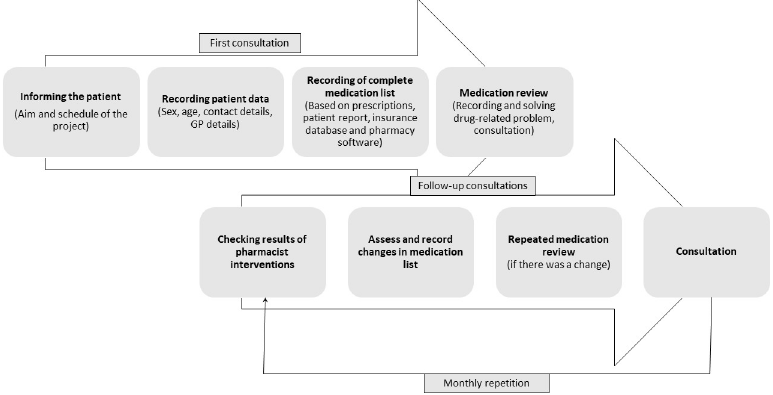
Fig 1. The procedure of pharmacist consultations during the first and the monthly follow-up sessions.